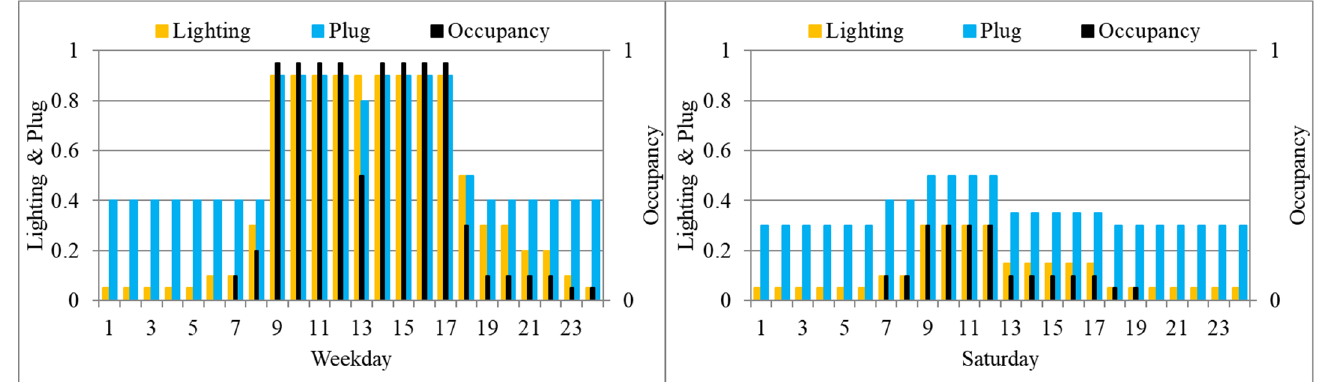
Figure 6. Representative input schedules of the simulation model [26,27].